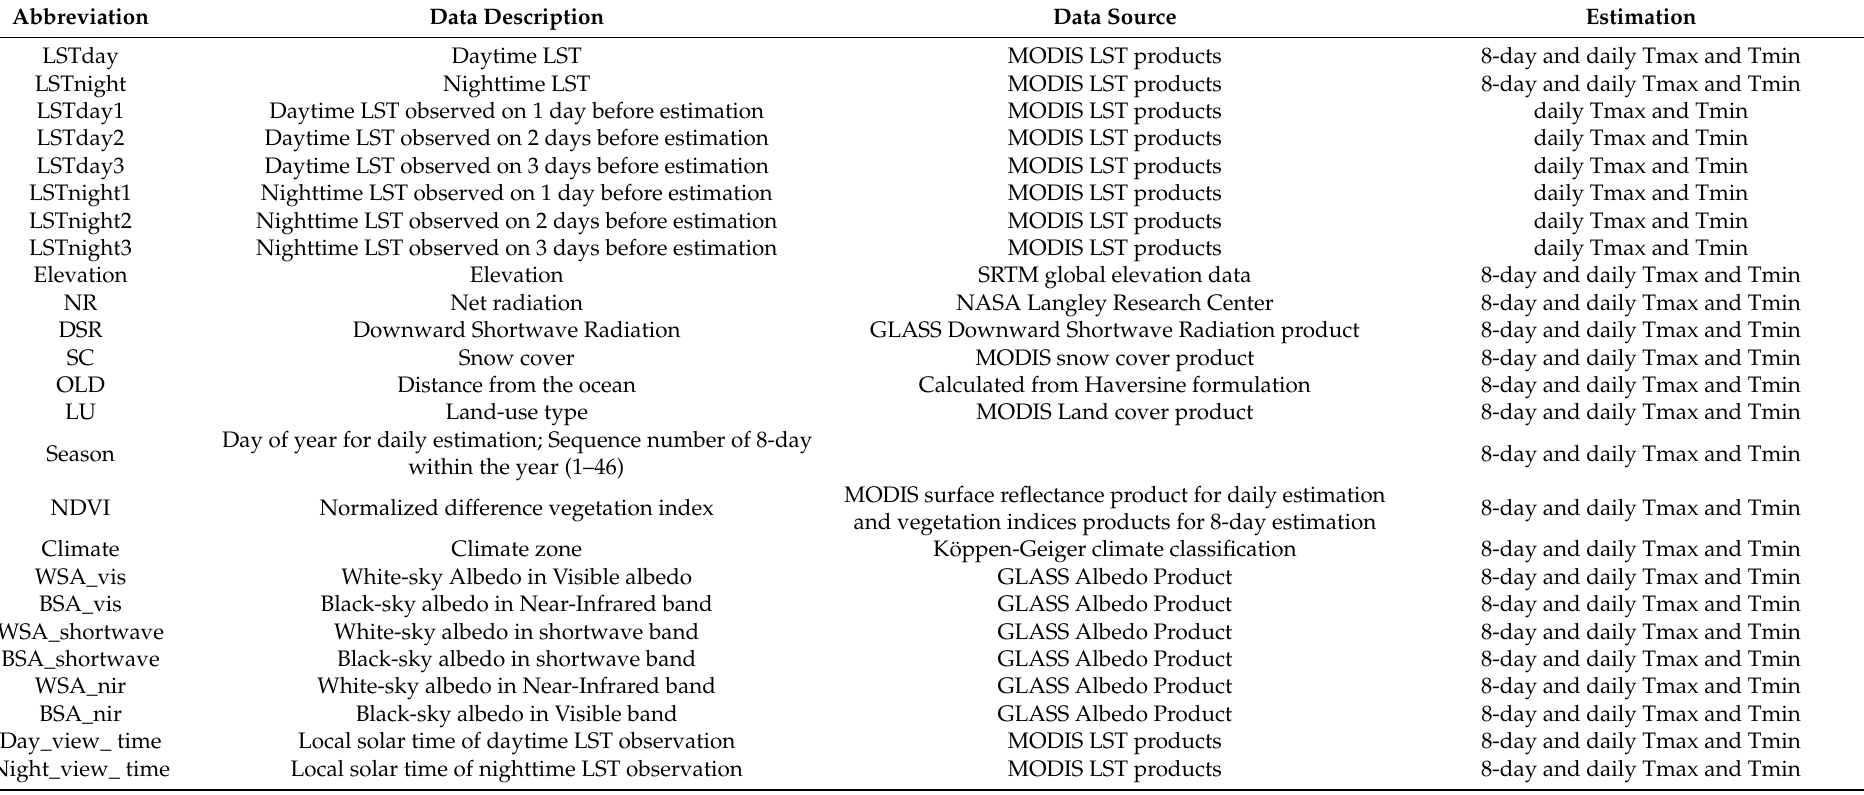
Table 1. The acronym and description of the variables used in this